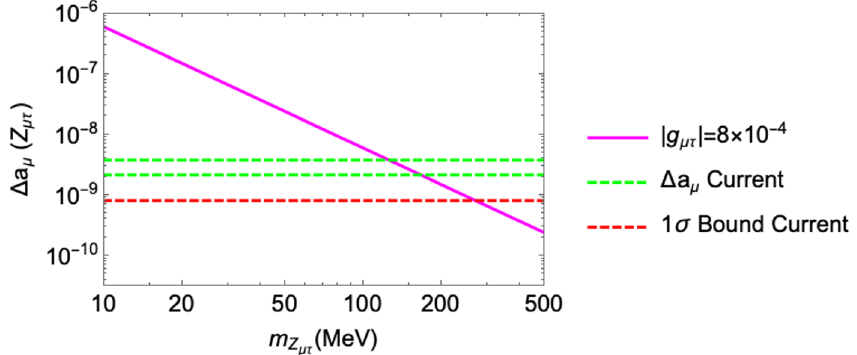
Figure 13 . Plot showing the contribution coming from new light gauge boson Z (cid:22)(cid:28) vs mass of Z (cid:22)(cid:28) . The magenta line shows the contribution of Z (cid:22)(cid:28) with coupling g (cid:22)(cid:28) = 8 anomaly with Z (cid:22)(cid:28) mass lying around 150